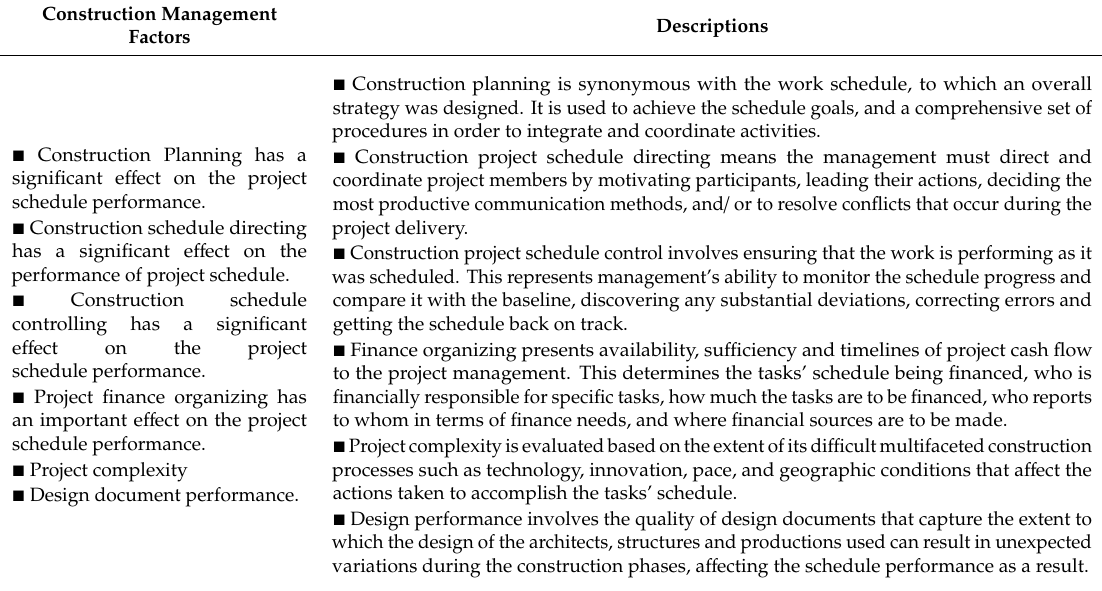
Table 1. Items on the